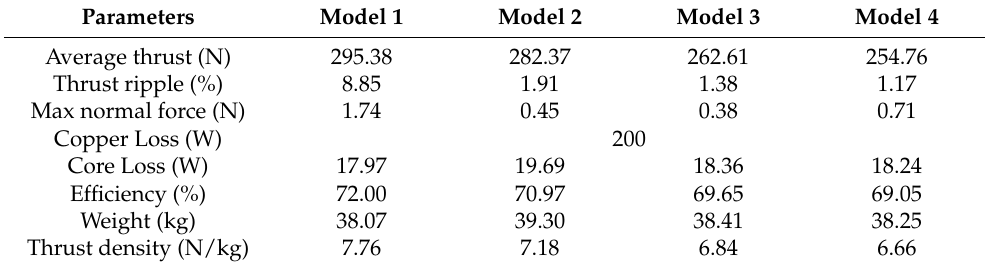
Figure 13. The thrust comparison of four possible combinations. Table 4. Performance of Four